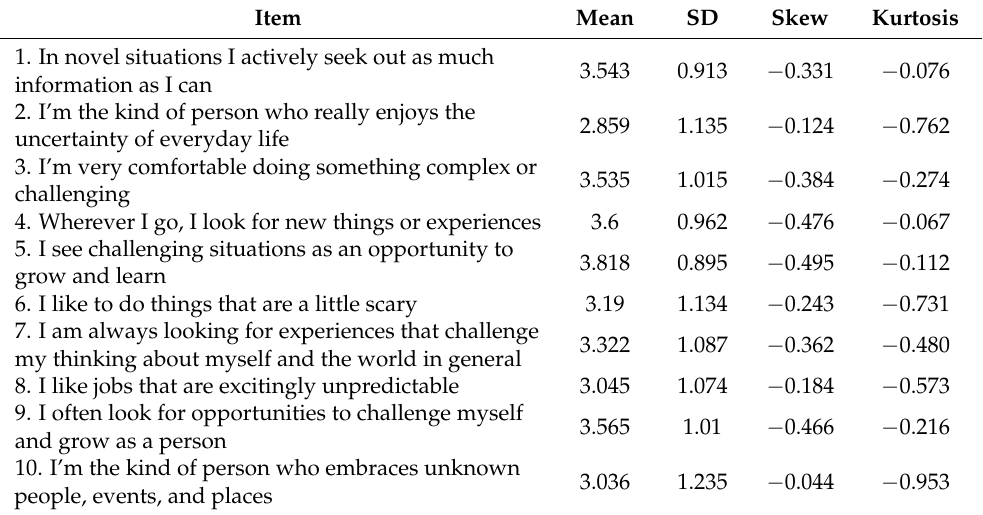
Table 1. Descriptive statistics of the CEI-II